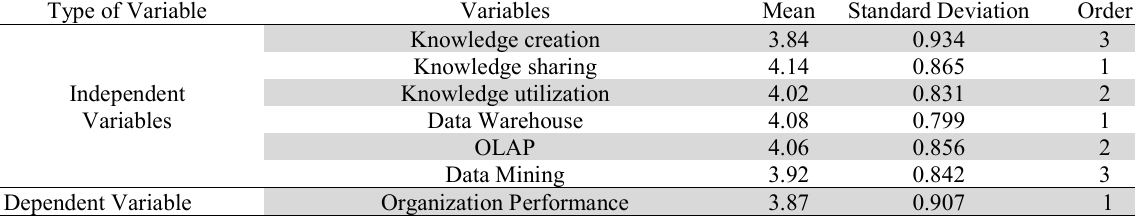
Mean and standard deviation of the research’s Variables Type of